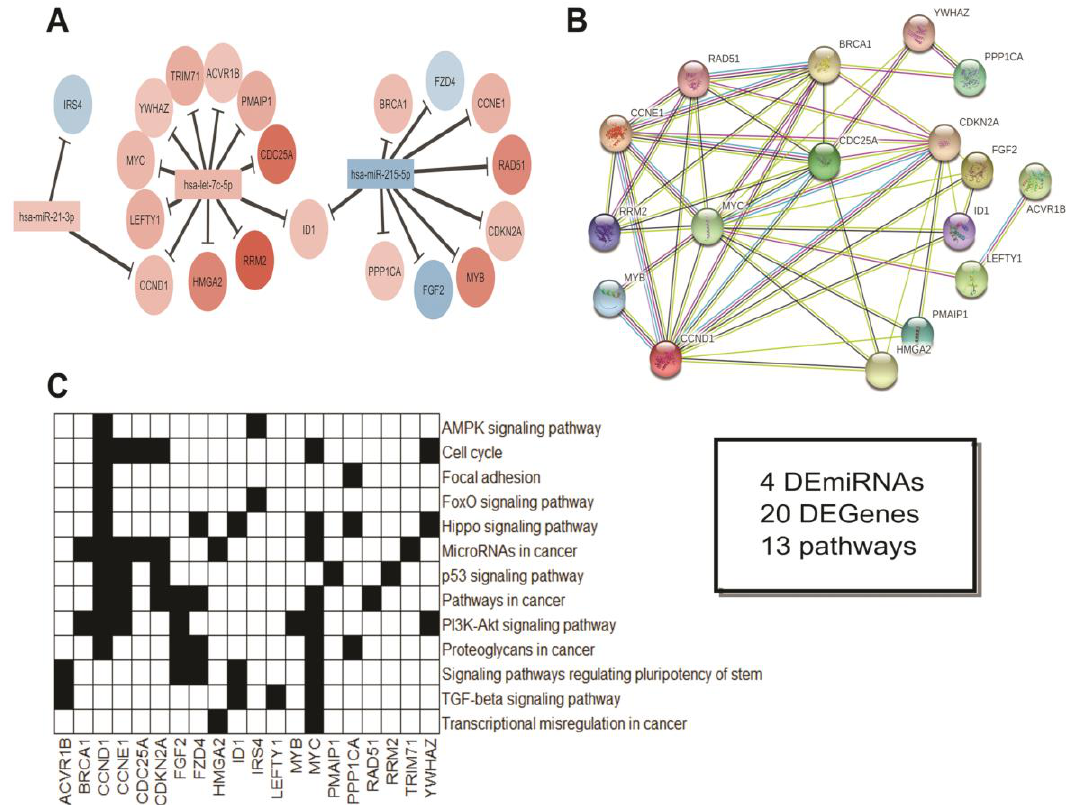
Figure 9. Integrative analysis of the DEmiRNAs in SCC vs. SCH. ( A ) miRNA-Gene and ( B ) Gene–Gene networks. In A, colors indicate if the miRNA or gene is up (red) or down (blue) expressed. miRNA Log 2 (Fold-Change) measures were obtained from our casuistic analysis, while gene Log 2 (Fold-Change) measures were obtained from TCGA and GTEx datasets. ( C ) Genes involved in the carcinogenic pathway, according to our functional annotation. The box indicates the total of miRNA and genes differentially expressed in this statistical comparison. Additionally, the total of pathways related to cancer was observed. Note: SCH = Sigmoid Colon Healthy. SCC = Sigmoid Colon Cancer. Disconnected nodes were hidden from the network view.